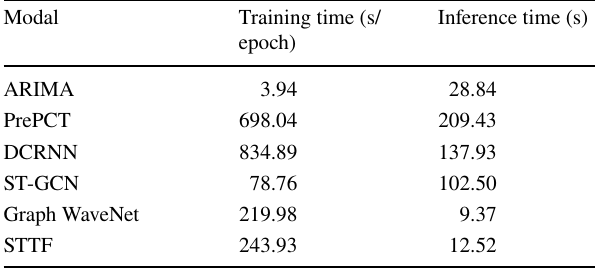
Table 6 Training and predicting efficiency of each model Modal Training time (s/